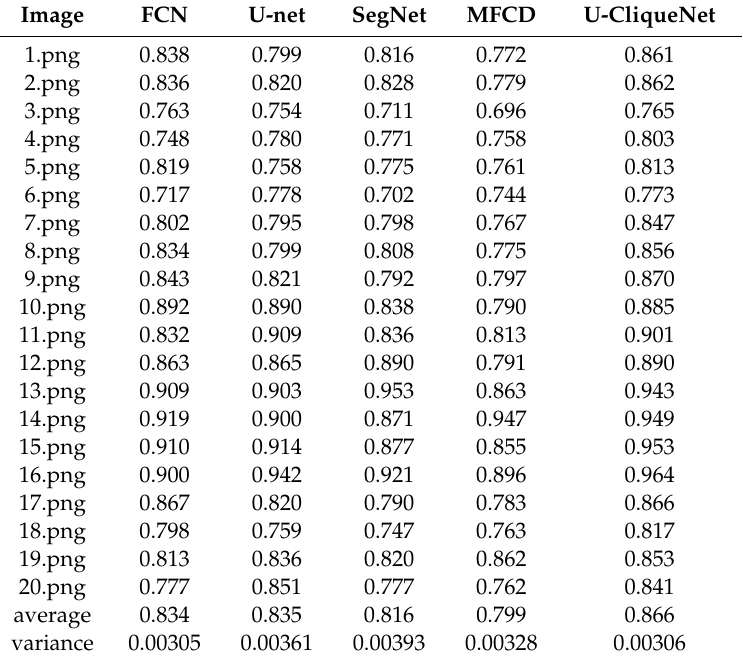
Table 5. The MIoU predicted by FCN, U-net, SegNet, MFCD and U-CliqueNet for randomly selected 20